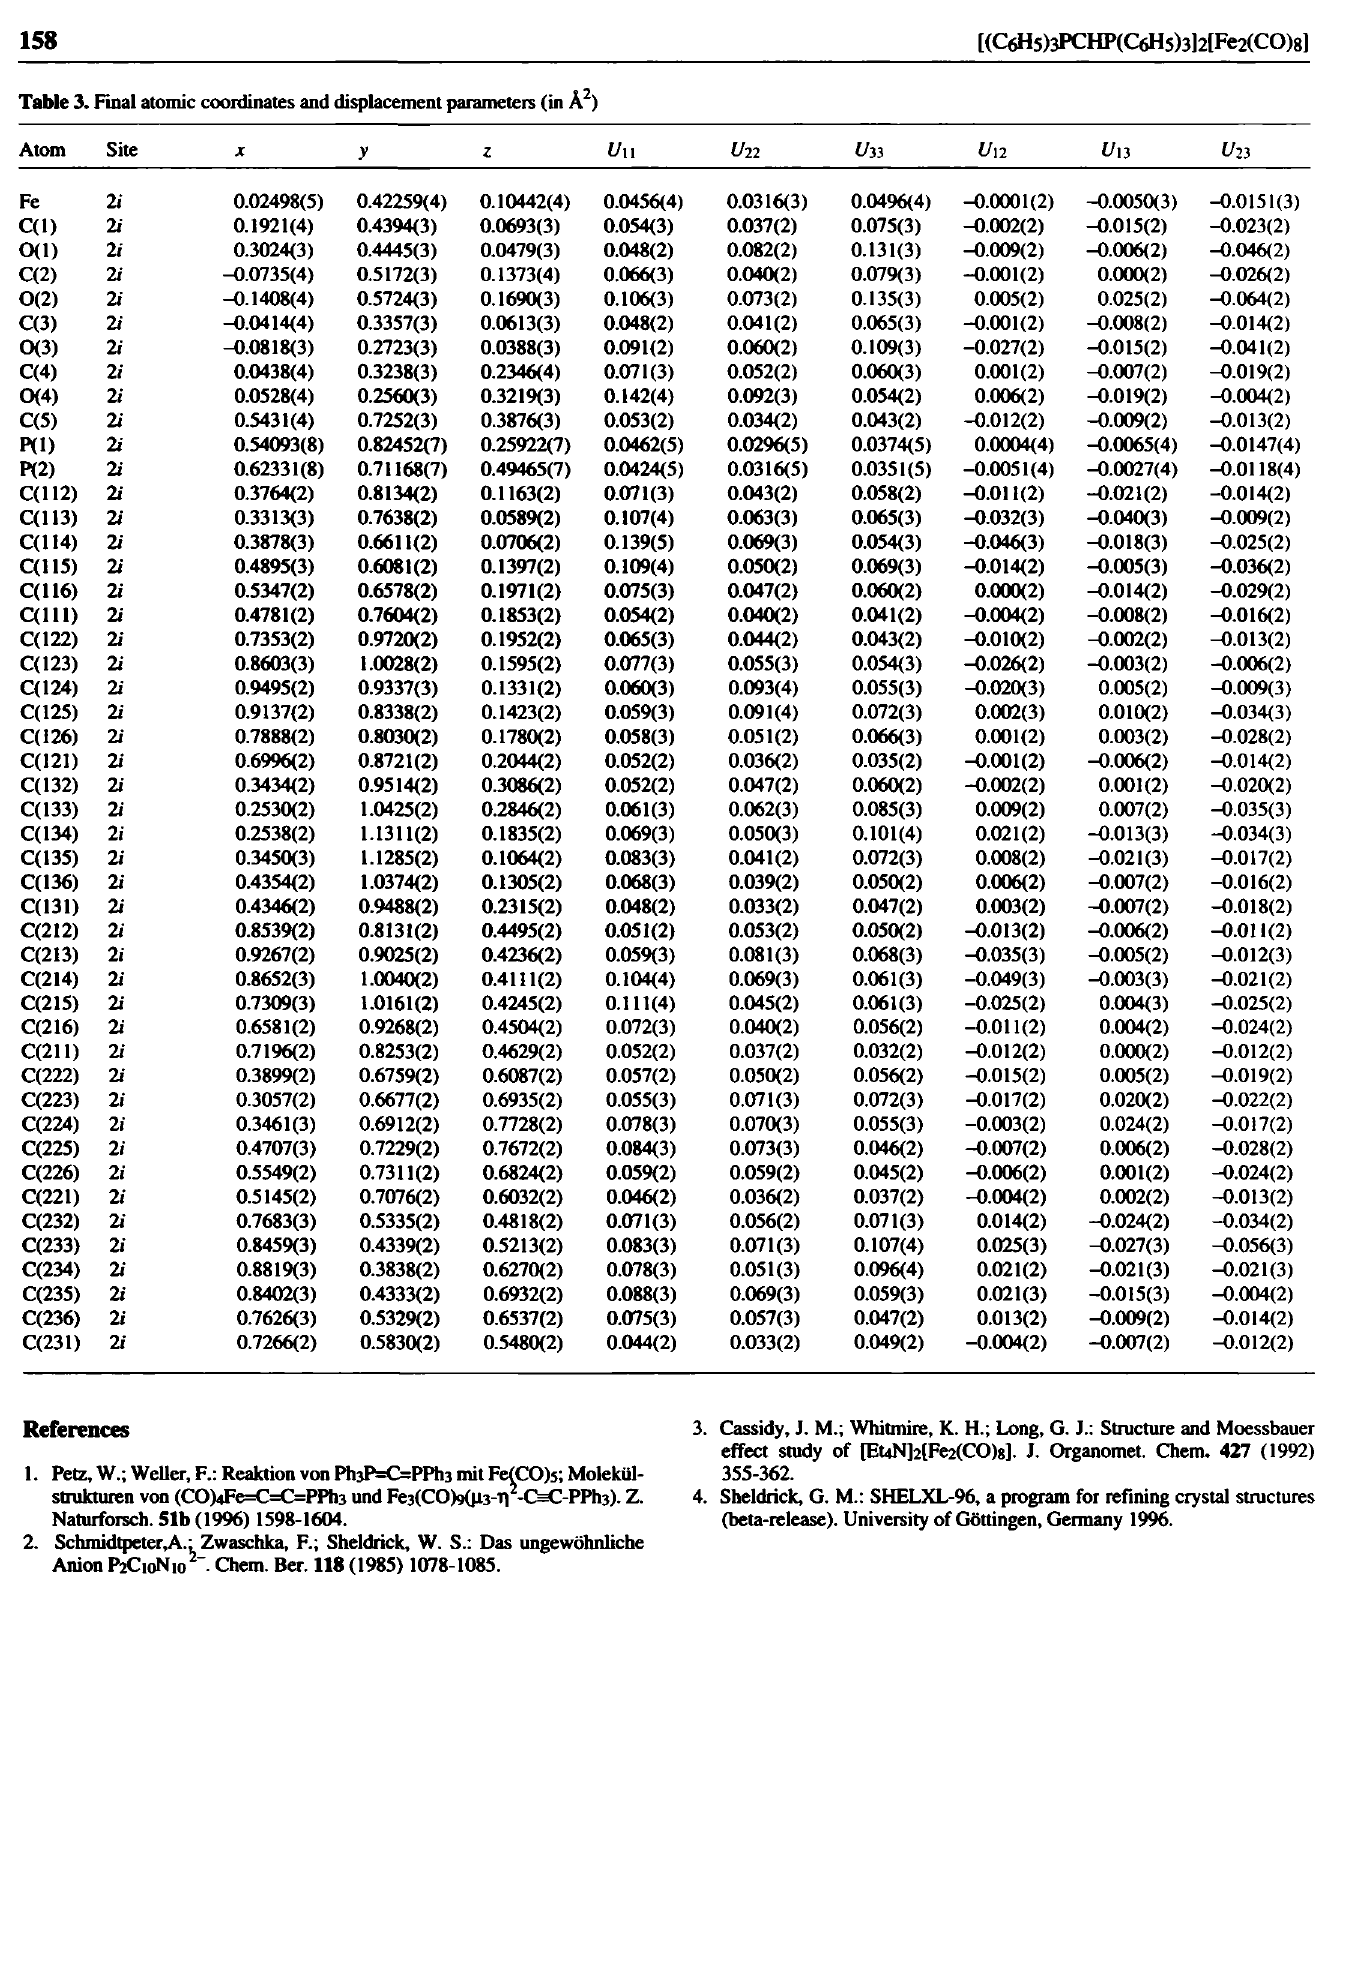
Table 3. Final atomic coordinates and displacement parameters (in Â 2